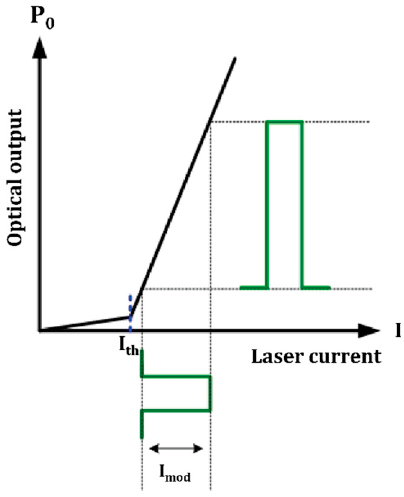
Figure 4. Laser modulation characteristics.